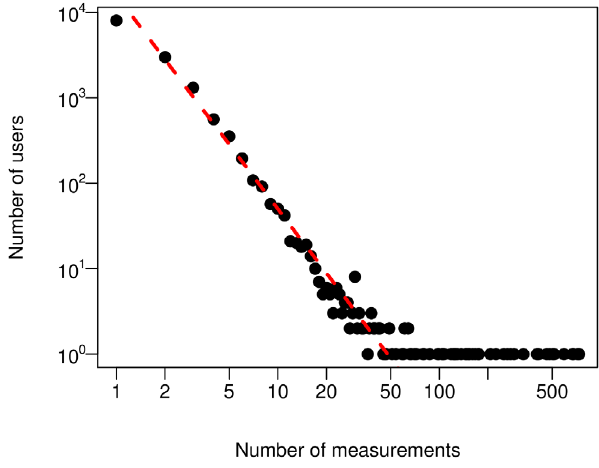
Figure 7. User activity distribution. Power-law compatible distribution of the number of measurements performed by each user. The red dashed line corresponds to a powerlaw of exponent 2 2.5.